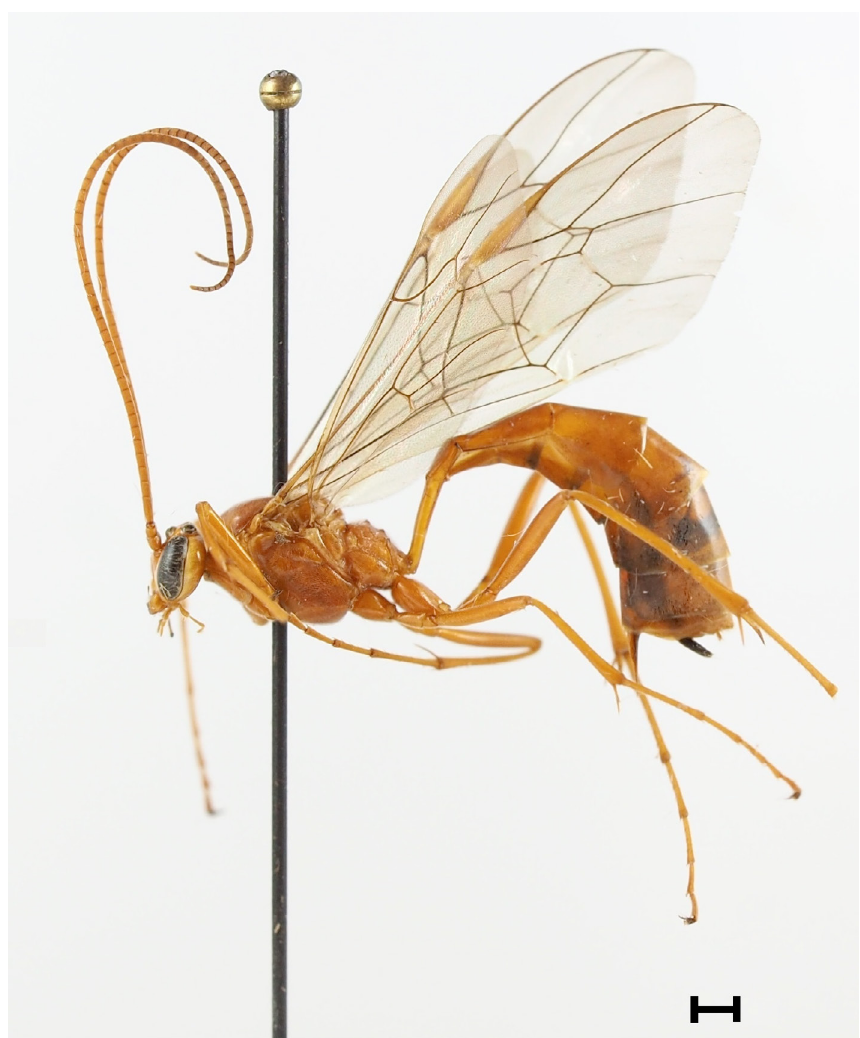
Fig. 22. Ophion angularis Johansson & Cederberg sp. nov., paratype, ♀ (MZLU 6366:3). Scale bar = 1